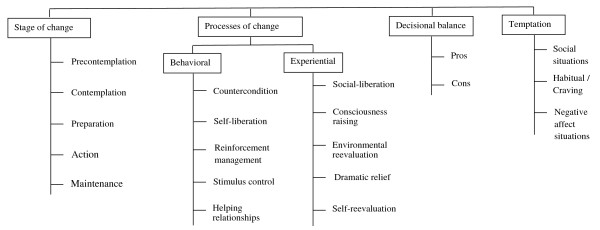
Schematic view of the transtheoretical model (TTM) constructs.